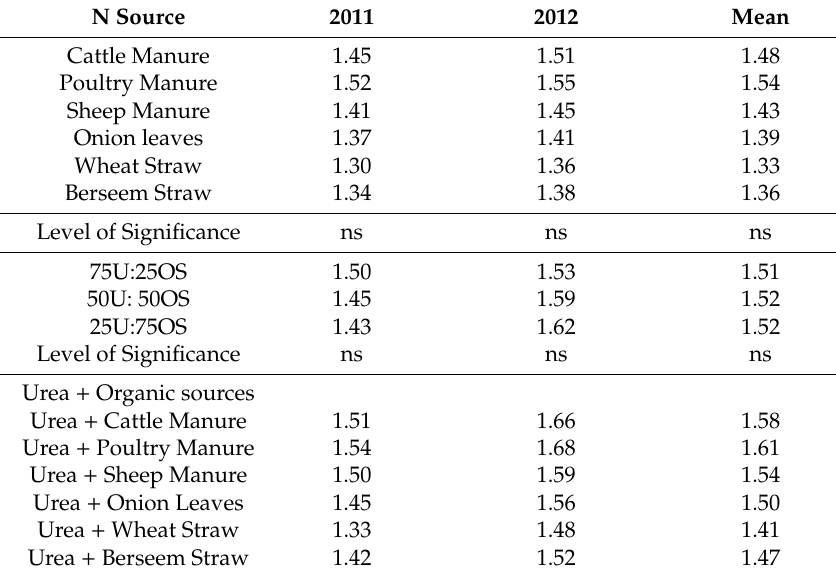
Table 4. Nitrogen concentration in grains (%) of rice hybrid “Pukhraj” as a ff ected by organic and inorganic